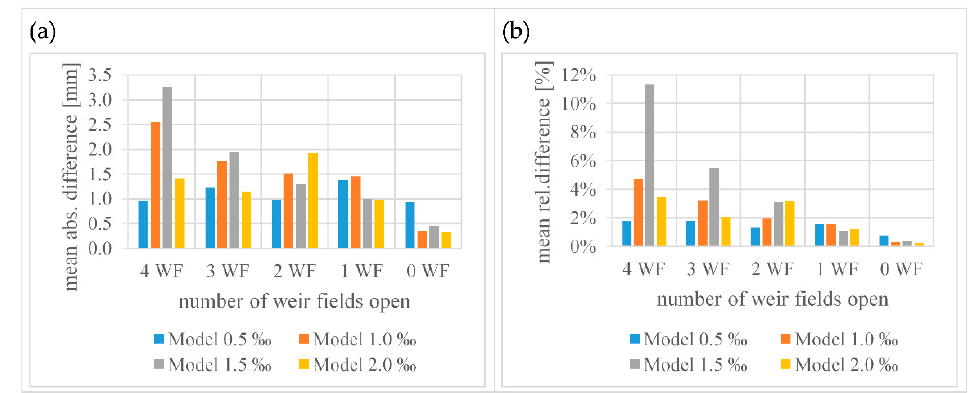
Figure 9. Mean absolute ( a ) and relative ( b ) difference of the flow depths h resulting from the numerical and the physical model.